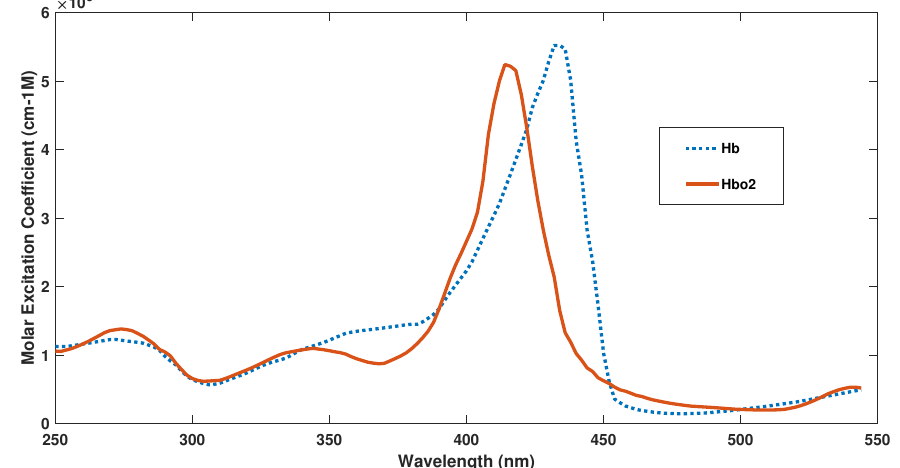
Figure 4. The graph shows the best-estimated spectrum of Hb and HbO 2 from the various sources by Scott Prahl Data [57].